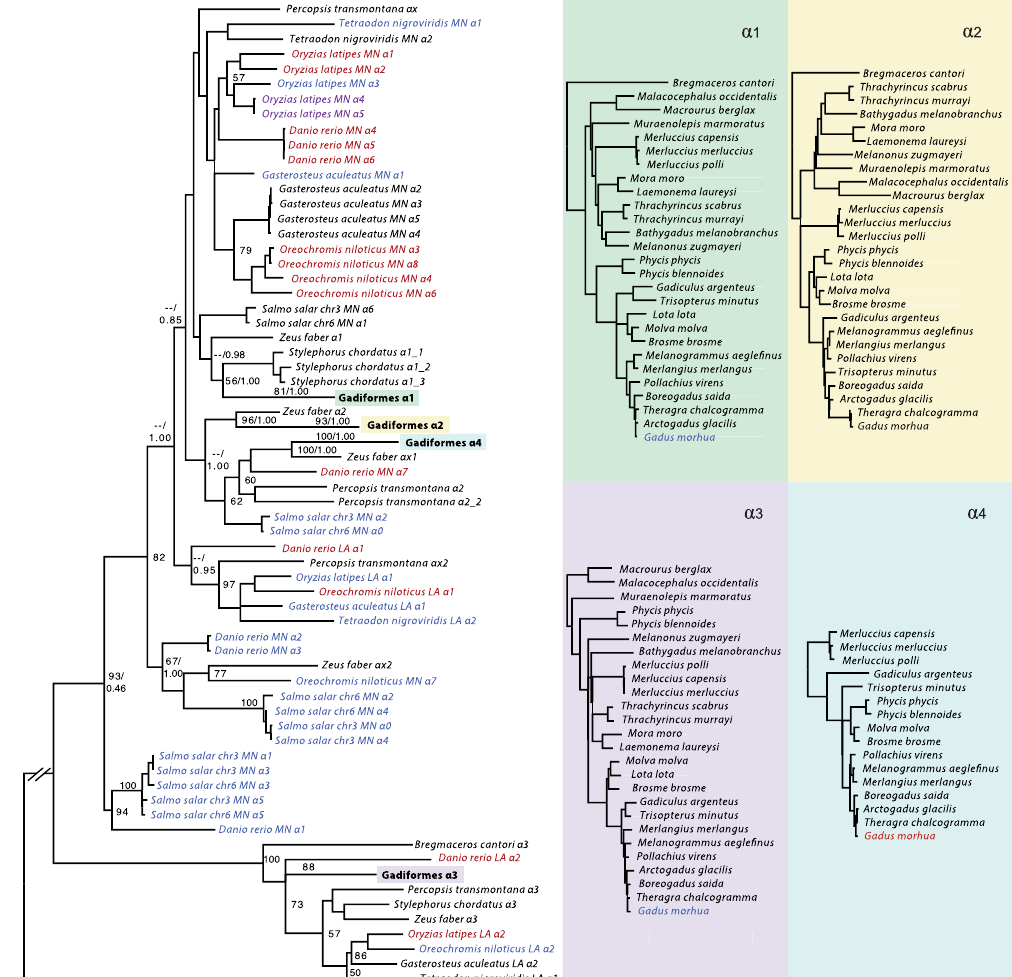
Figure 2. Phylogenetic relationships of α -globin genes. ML phylogeny of α -globin genes from 36 species of teleosts, and western clawed frog ( Xenopus tropicalis ) as the outgroup species. Numbers on nodes show bootstrap values and Bayesian posterior probabilities where topology is concordant, -- denotes support lower than 50/0.50. Sequences are colored according to timing of expression 11, 45 ; embryonic (red), adult (blue), embryonic and adult (purple) and unknown (black). For each gadiform α -globin gene the phylogenetic tree is shown separately. Some branches are shortened for convenience, which is indicated by